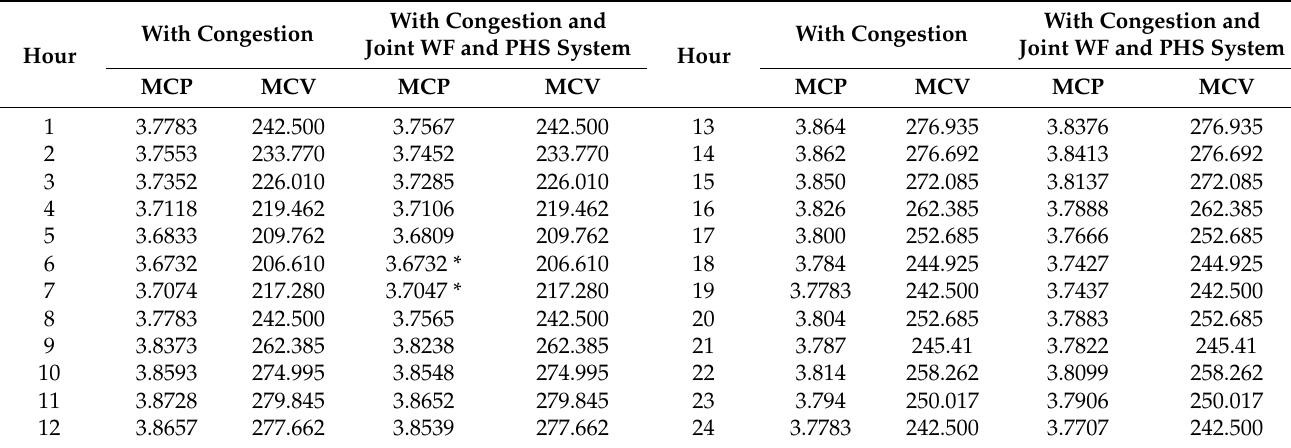
* without WPHS system power.